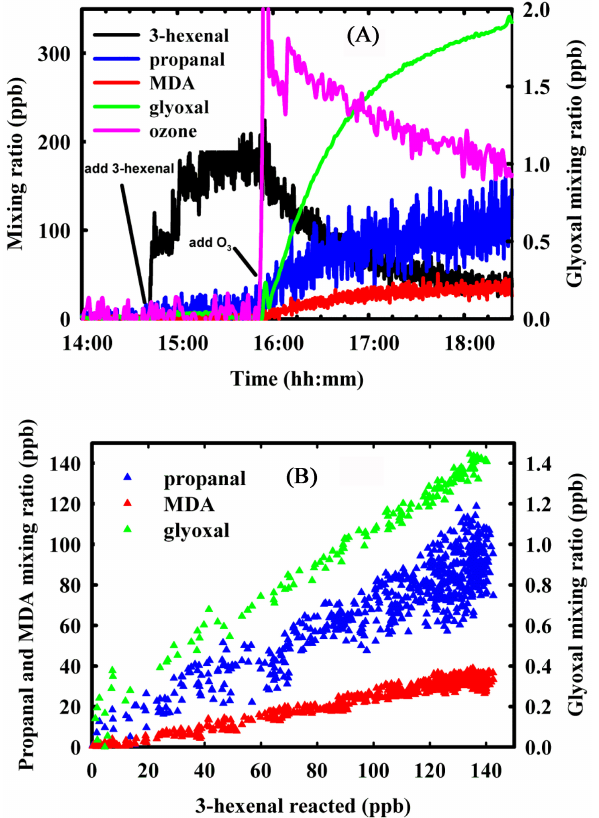
Fig. 7. (A) Time series of the reactants and products and (B) for the reaction of gas-phase 3-hexenal with ozone in the Teflon